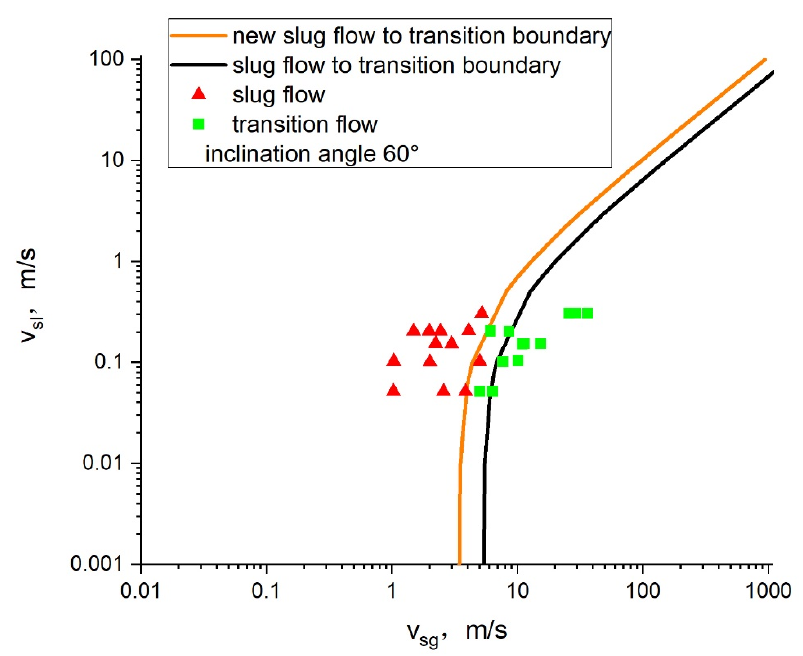
Figure 7. The boundary for discrimination of the transition from slug flow to turbulent flow.